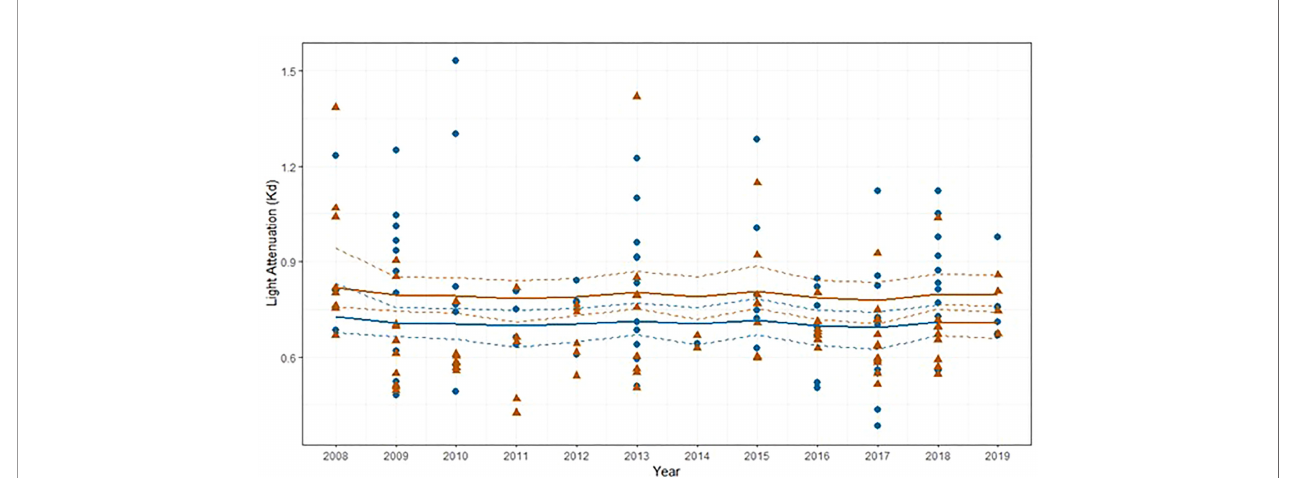
FIGURE 10 | Calculated light attenuation coef fi cients (Kd) to 1 m depth at WQ2 (brown triangles) and WQ3 (blue circles) in Back Sound NC. Solid lines represent mean fi tted values from gamma regression with temporal correction factor and dotted lines represent 95% con fi dence